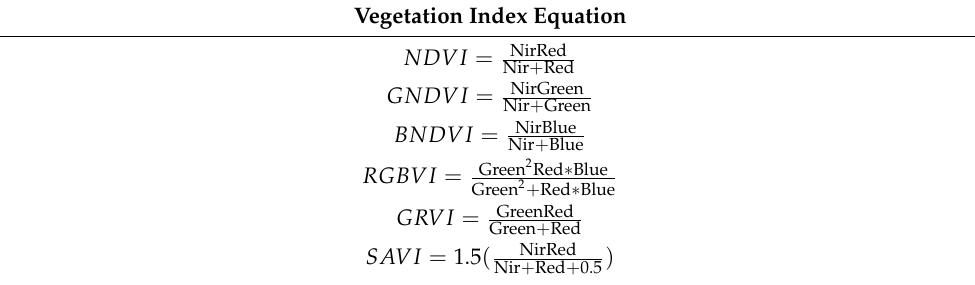
Table 3. Existing vegetation index equations. Vegetation Index Equation